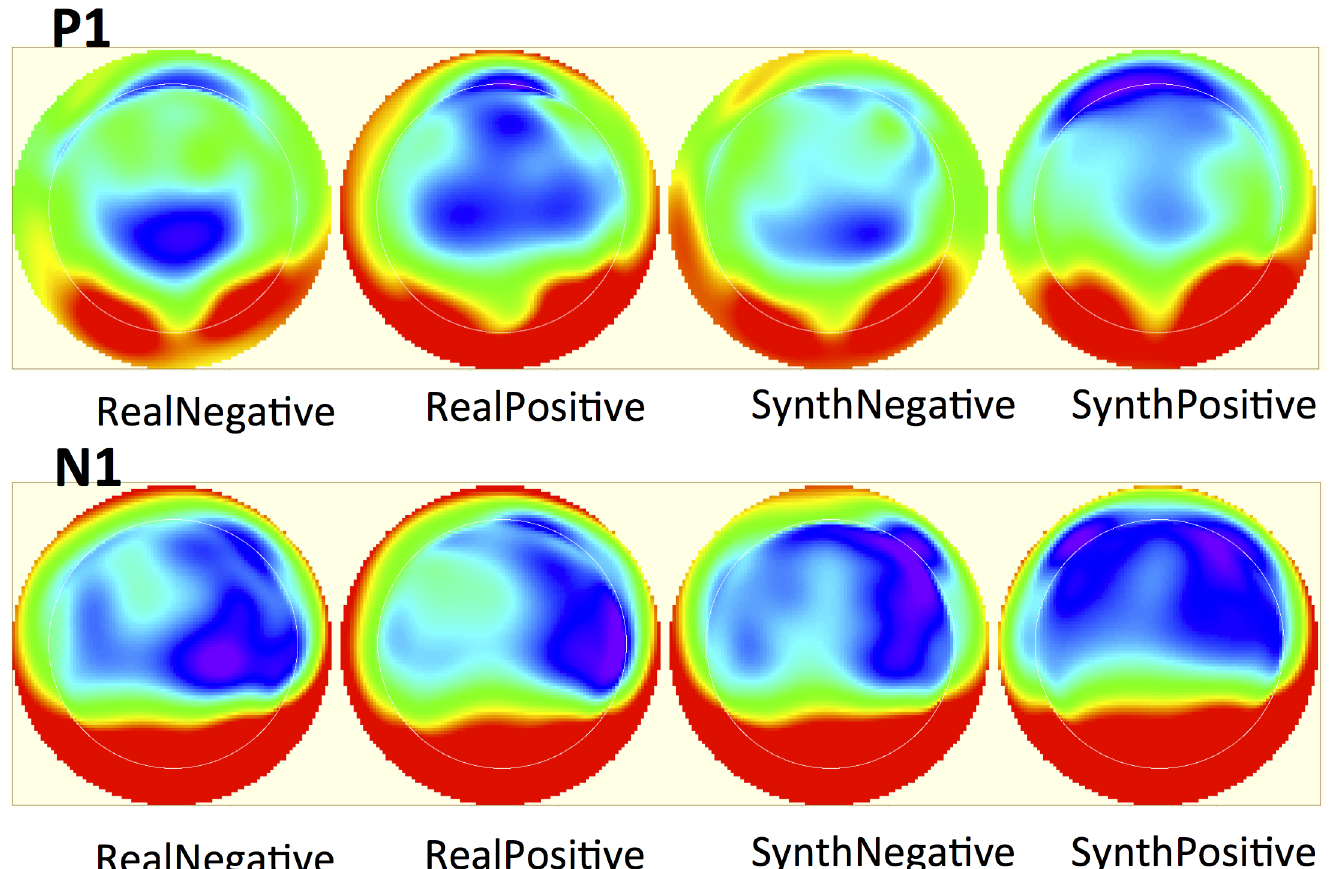
Fig 5. A topographic heat map of the entire scalp for both the P1 and N1 in all stimulus conditions. Warm colors signify more positive values, cool colors signify more negative